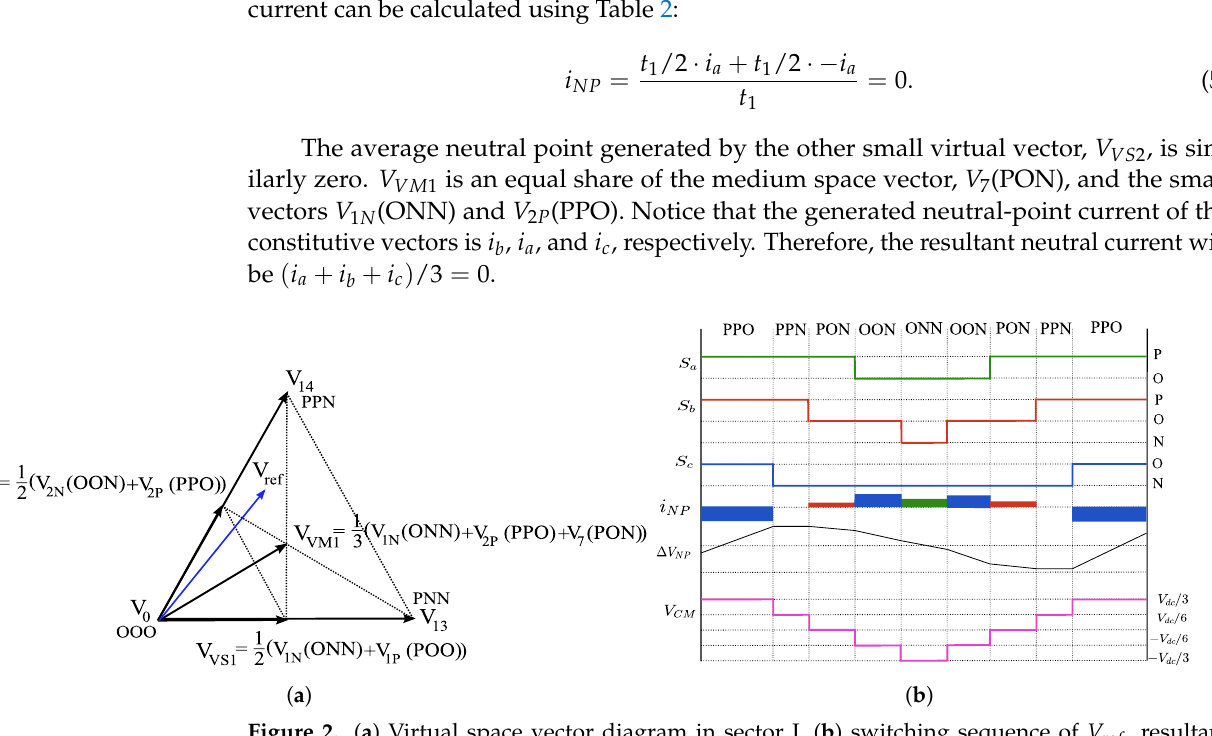
Figure 2. ( a ) Virtual space vector diagram in sector I, ( b ) switching sequence of V ref , resultant neutral-point current, NPV variations, and the generated V CM . (Green: phase a; Red: phase b; Blue: phase